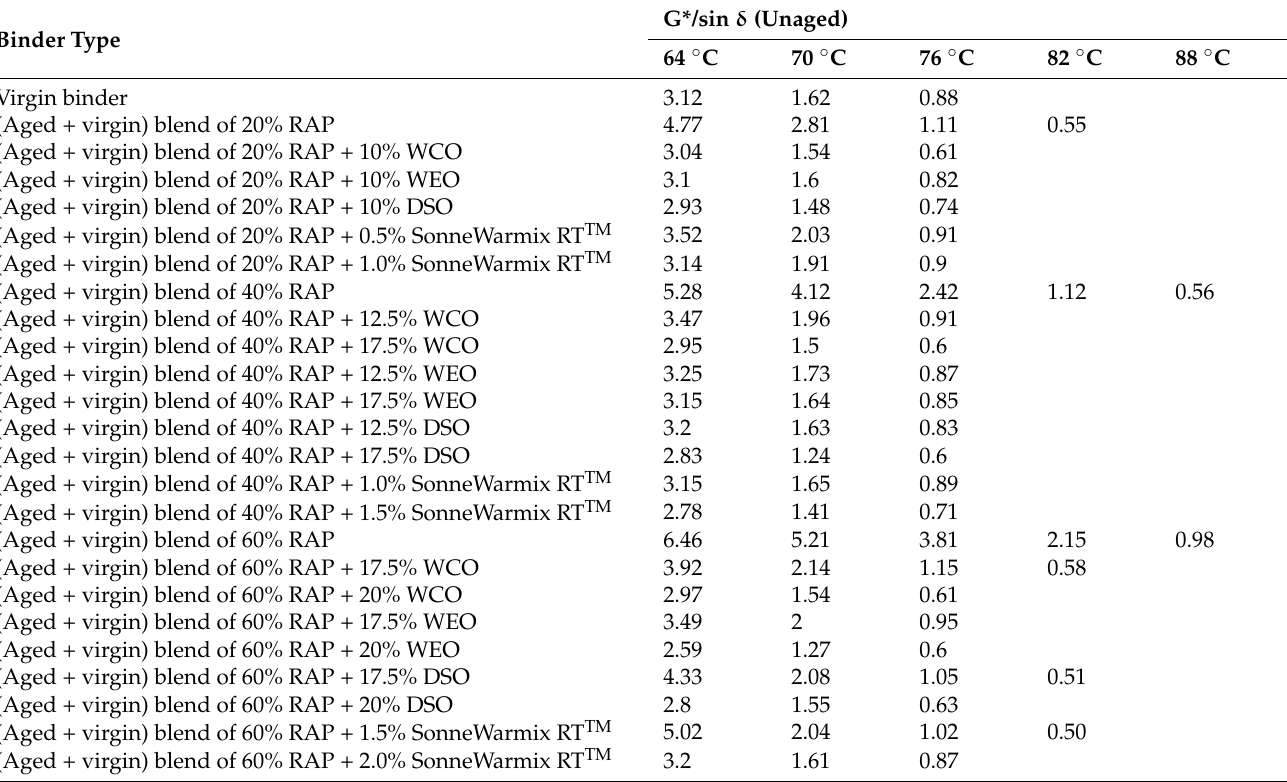
Table 19. Rutting indicator (G*/sin δ ) for the unaged samples of the binders’